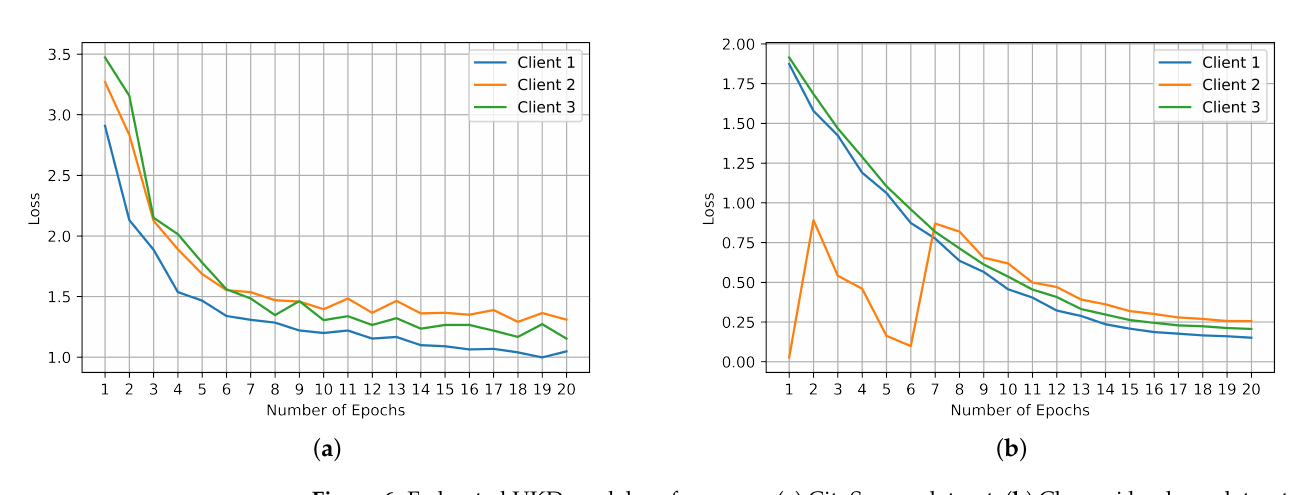
Figure 6. Federated UKD model performance. ( a ) CityScapes dataset; ( b ) Chennai land use dataset.